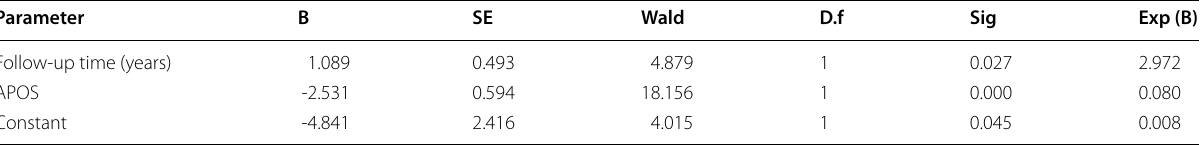
Table 6 Logistic regression analysis between variables ( P < 0.2) and